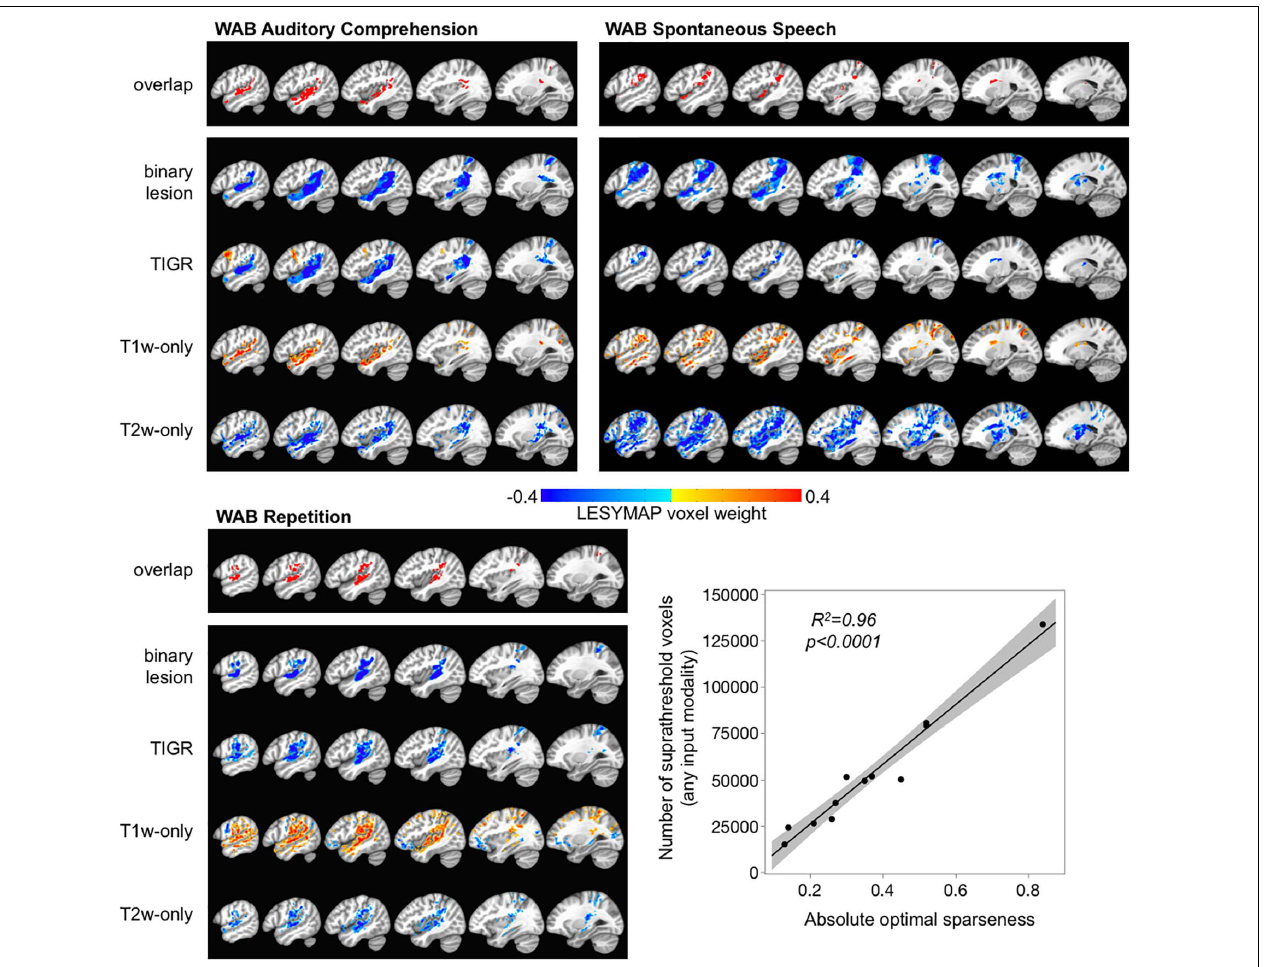
FIGURE 5 | Multivariate brain–behavior relationships for WAB auditory comprehension, WAB repetition, and WAB spontaneous speech using binary lesion, tissue integrity gradation via T2w T1w ratio, T1w-only, and T2w-only maps. The overlapping map across the top for each behavior shows which brain areas were identified across all modalities for comparison purposes. The color bar represents LESYMAP voxel weights. The location of brain–behavior maps is similar across all modalities, but the extent of the maps differs based on the LESYMAP internally computed optimal sparseness (regression